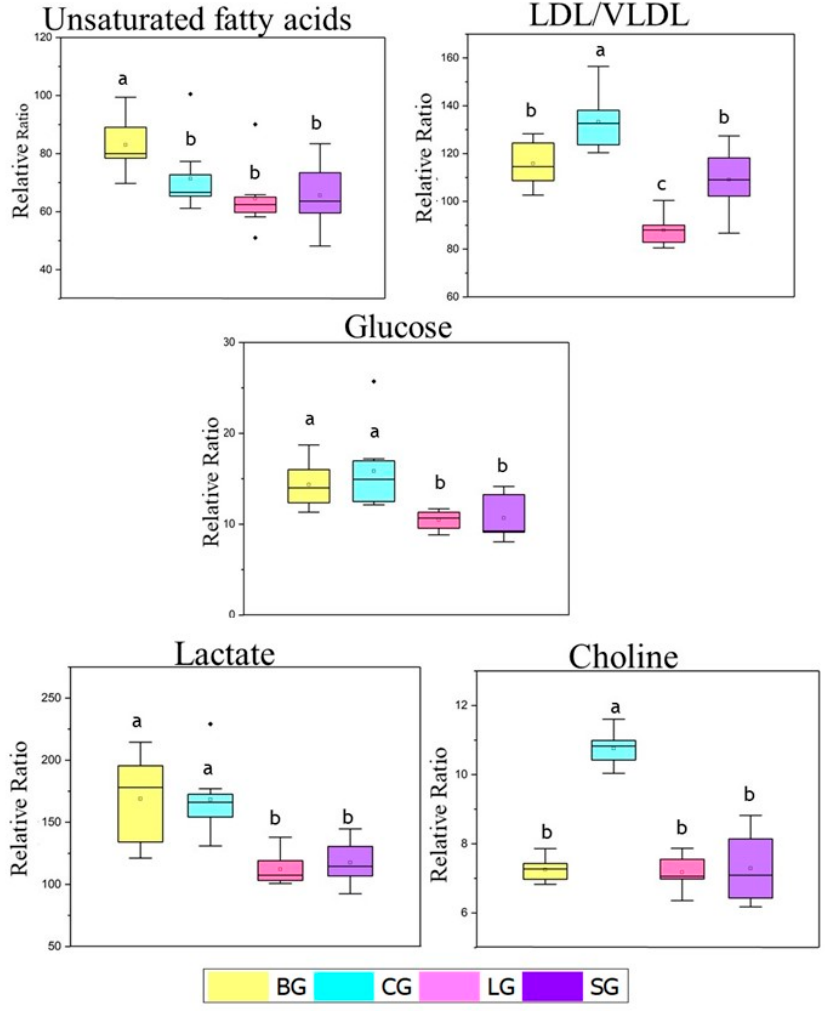
Figure 3. Relative proportion of unsaturated fatty acid, LDL/VLDL, glucose, choline, and lactate metabolites identified from 1 H NMR spectra in the serum of mice fed with baru, coconut, linseed, and soybean oils. The relative ratio was obtained by integrating the relevant signals with reference to the DSS-d-6 signal Differences within unsaturated fatty acids and glucose levels were tested with Krus-kal–Wallis and Mann–Whitney tests. Differences within LDL/VLDL, choline and lactate levels were tested with ANOVA tests. The same letters represent no significative differences. Legend: baru